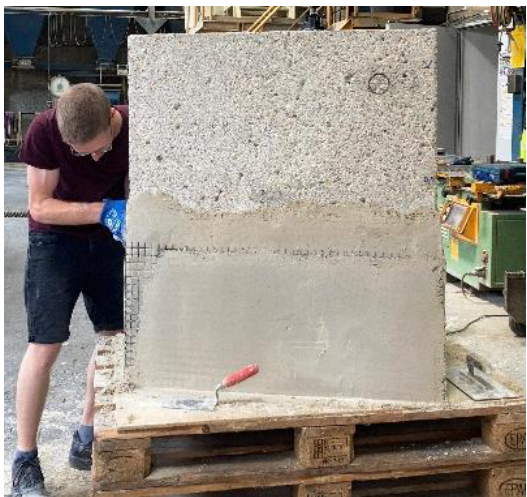
Figure 7. Scale 1:1 trial repair (© Jeanette Orlowsky).